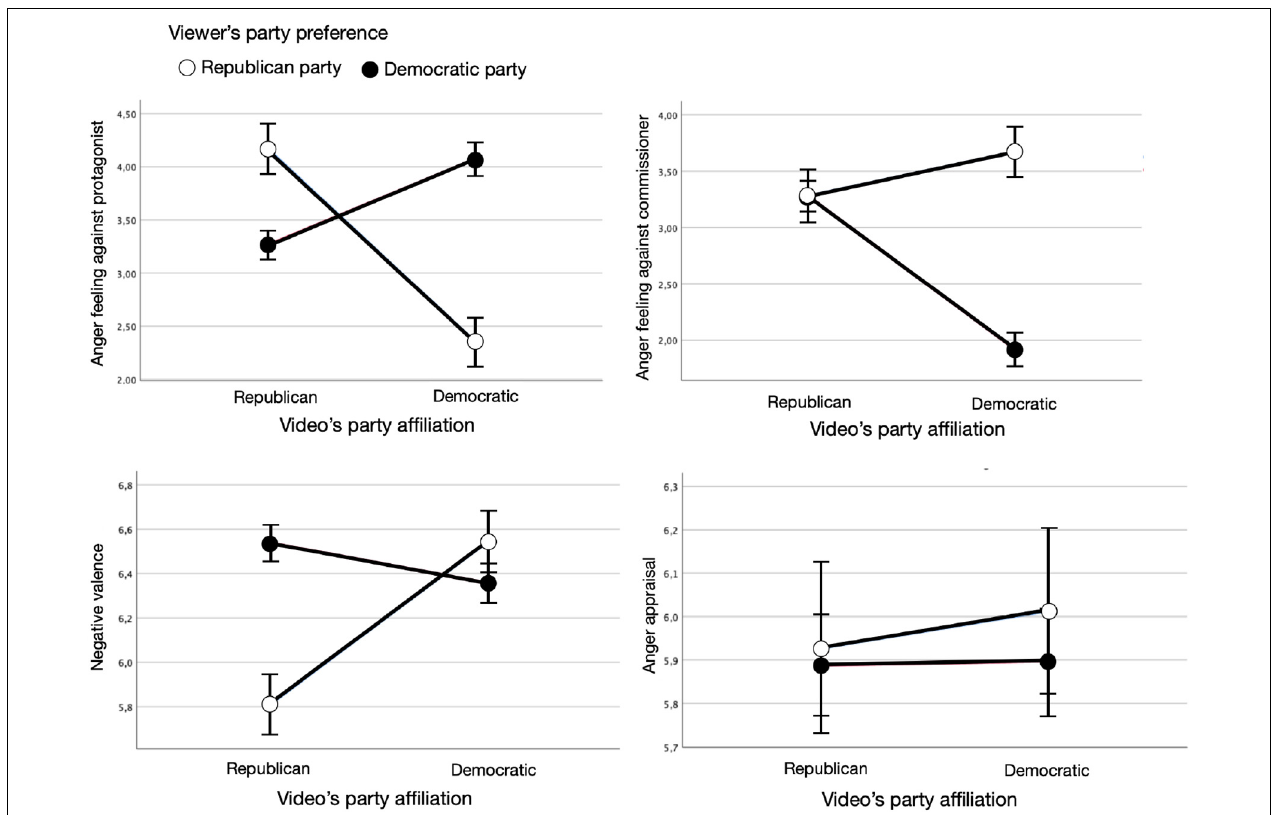
FIGURE 2 | Interaction effects of video’s guessed party affiliation and viewer’s party preference on the four components of anger: feeling against protagonist, feeling against commissioner, negative valence, and